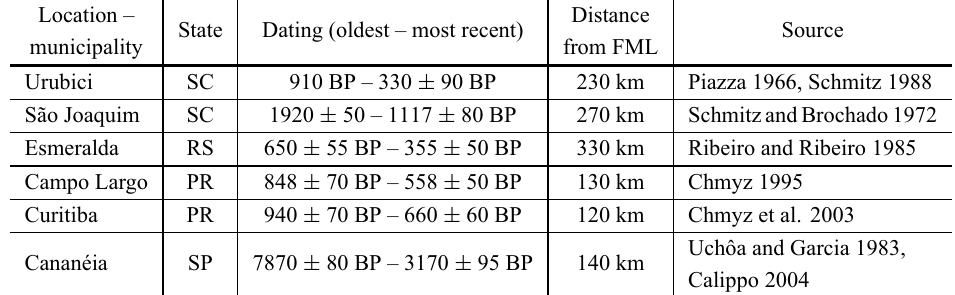
TABLE II 87 Sr/ 86 Sr isotope ratio in individuals buried at the Forte Marechal Luz site, organized by burial number. M (molar); P (premolar); I (incisor); L (left); R